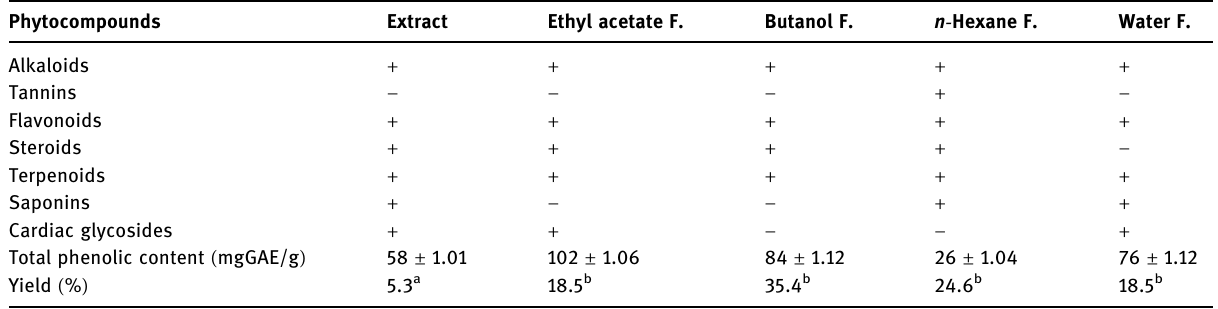
Table 1: Total phenolic content, yield, and phytocompounds present in the extract and fractions Phytocompounds